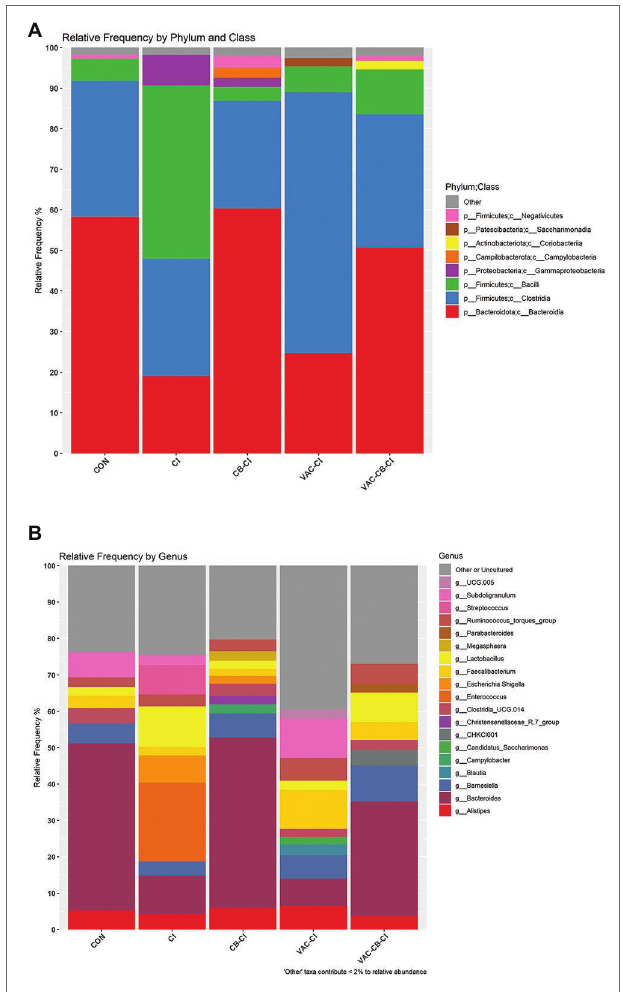
FIGURE 8 | Relative abundance of intestine microbiome taxa from samples pretreated with Clostridium butyricum and coccidiosis vaccine and then challenged with Eimeria sp. The relative abundances of gut bacteria presented in the plot were calculated by averaging the data obtained from the four replicates within each group. The relative abundance of microbial taxa was performed at two classification levels, class (A) and genus (B) . At the class level, the taxa with an overall abundance of less than 1% were summed into “other.” At the genus level, the overall abundance was less than 2% and “uncultured” is classified as “other or